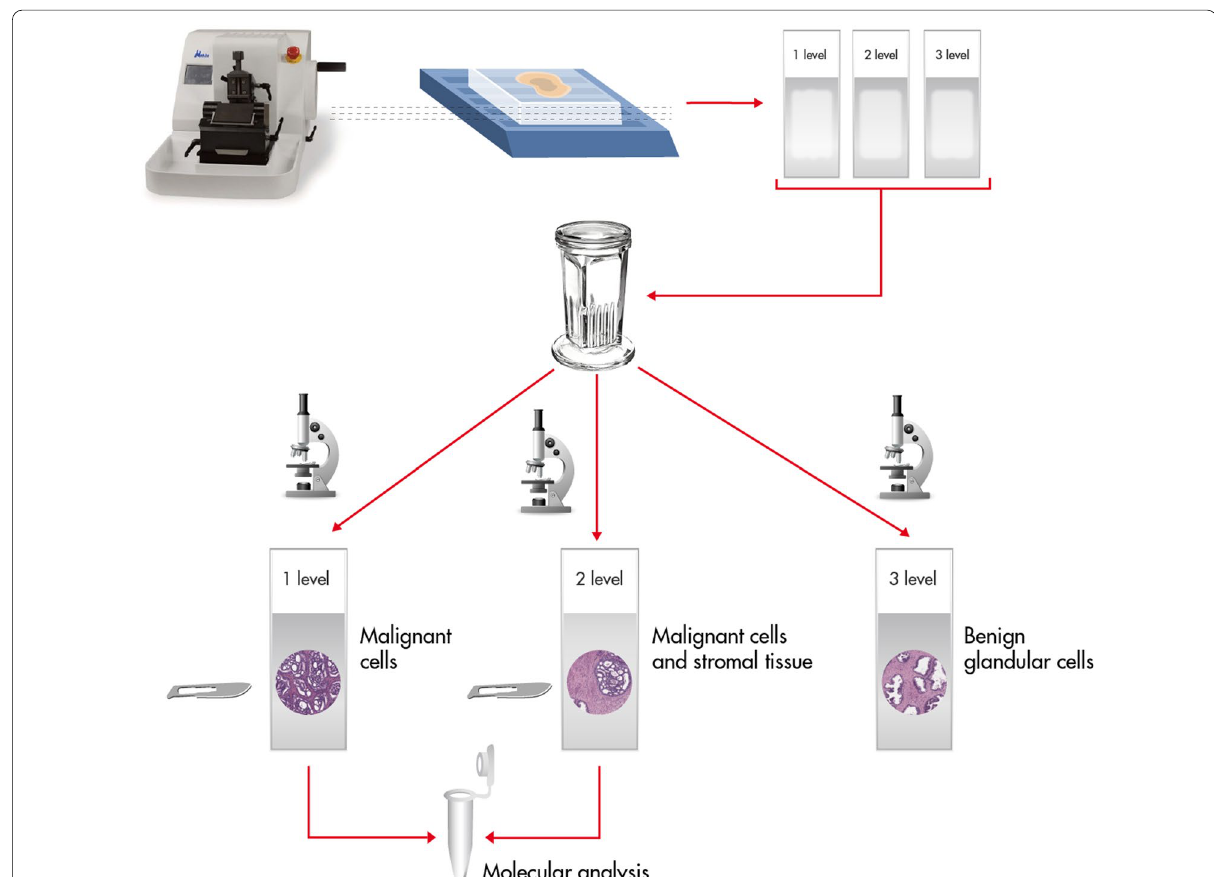
Fig. 2 Tissue obtained from microdissection. The tissue is cut with a microtome and unstained slides are obtained. These slides are deparaffinized (Table 1). The pathologist can choose the malignant cells and extracts the tissue with a blade under microscopy. For example, the whole slide in the first level, only glandular malignant cells in the second level. The third level has benign glandular cells. Therefore, only the tissue from first and second levels are sent for molecular